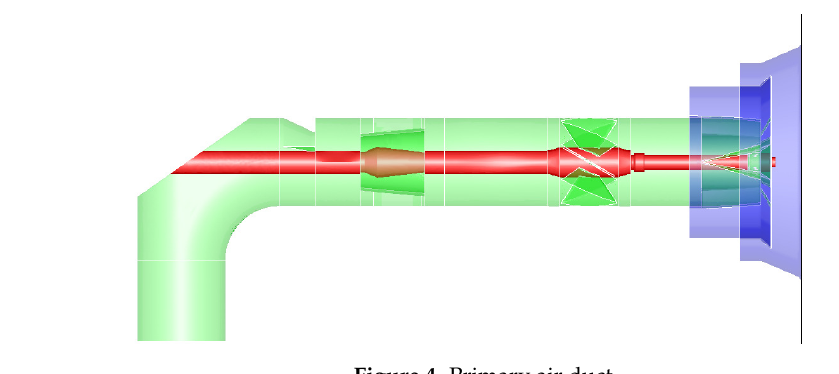
Figure 4. Primary air duct.